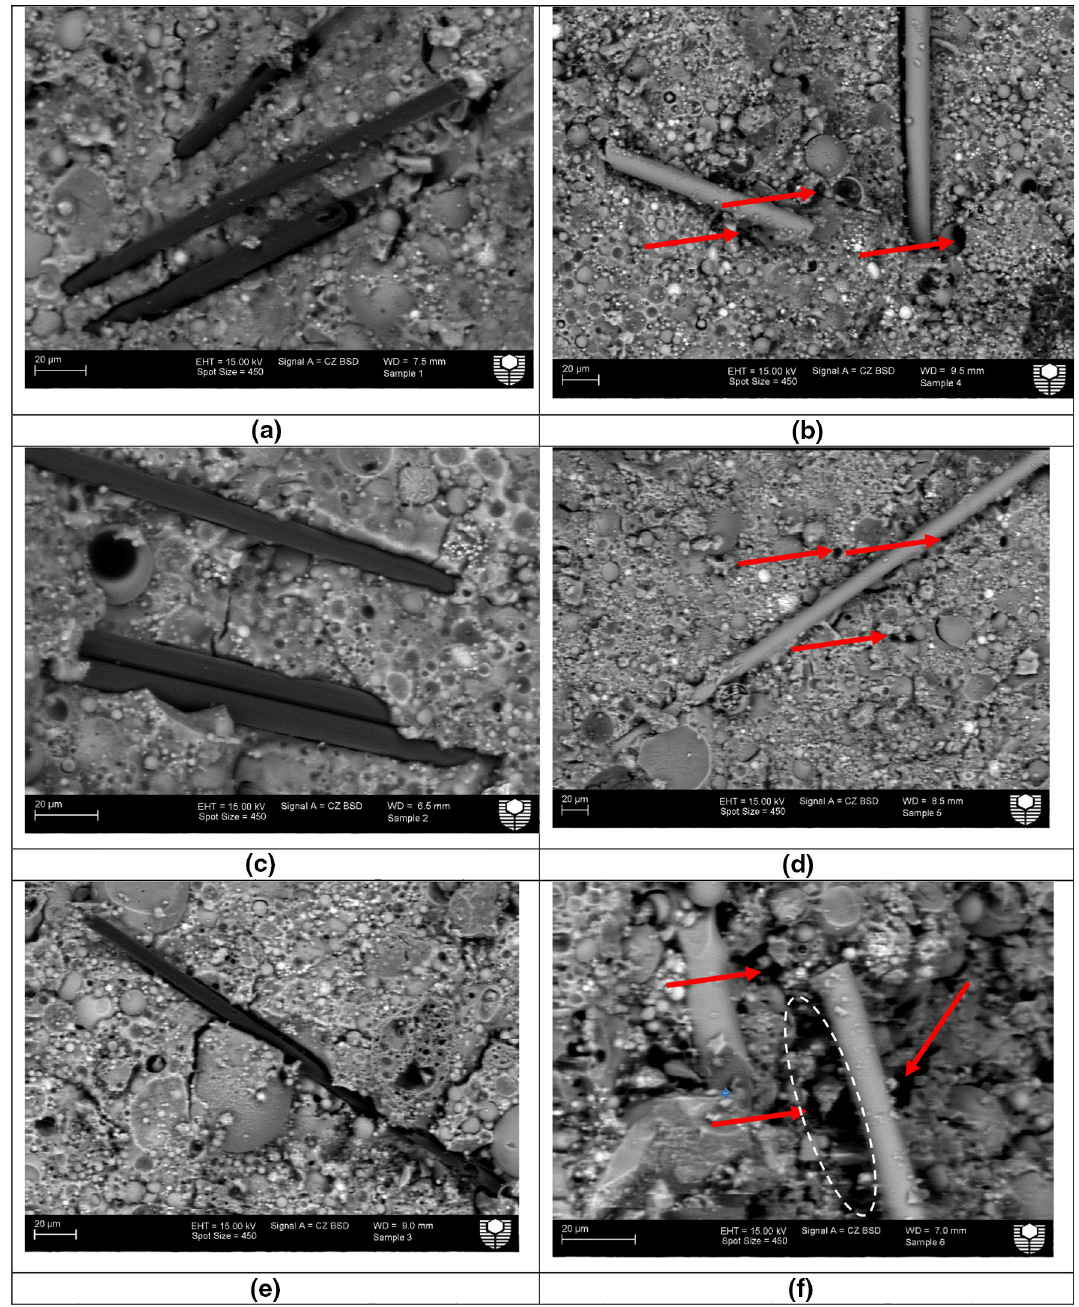
Fig. 10 SEM images of fly ash based geopolymer with carbon and basalt fibre at different elevated temperatures. a Carbon fiber (ambient temperature), b Basalt fiber (ambient temperature), c Carbon fiber (400 (cid:2) C temperature), d Basalt fiber (400 (cid:2) C temperature), e Carbon fiber (800 (cid:2) C temperature), and f Basalt fiber (800 C temperature) [arrows in b , d and f indicate the voids/pores in basalt fibre